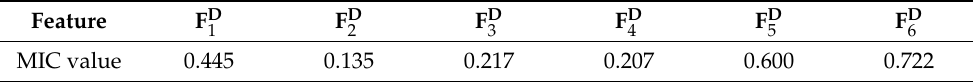
Table 8. Maximal information coefficient (MIC) of features for detection in this